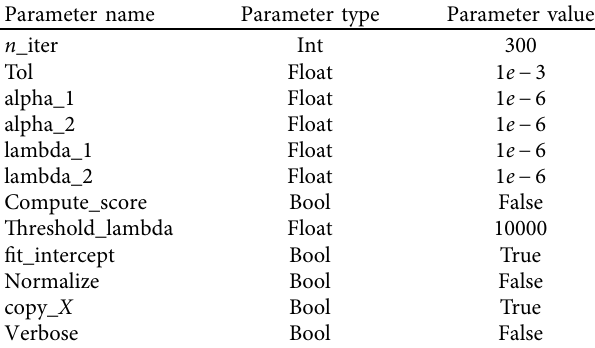
Table 3: The value of eight parameters of